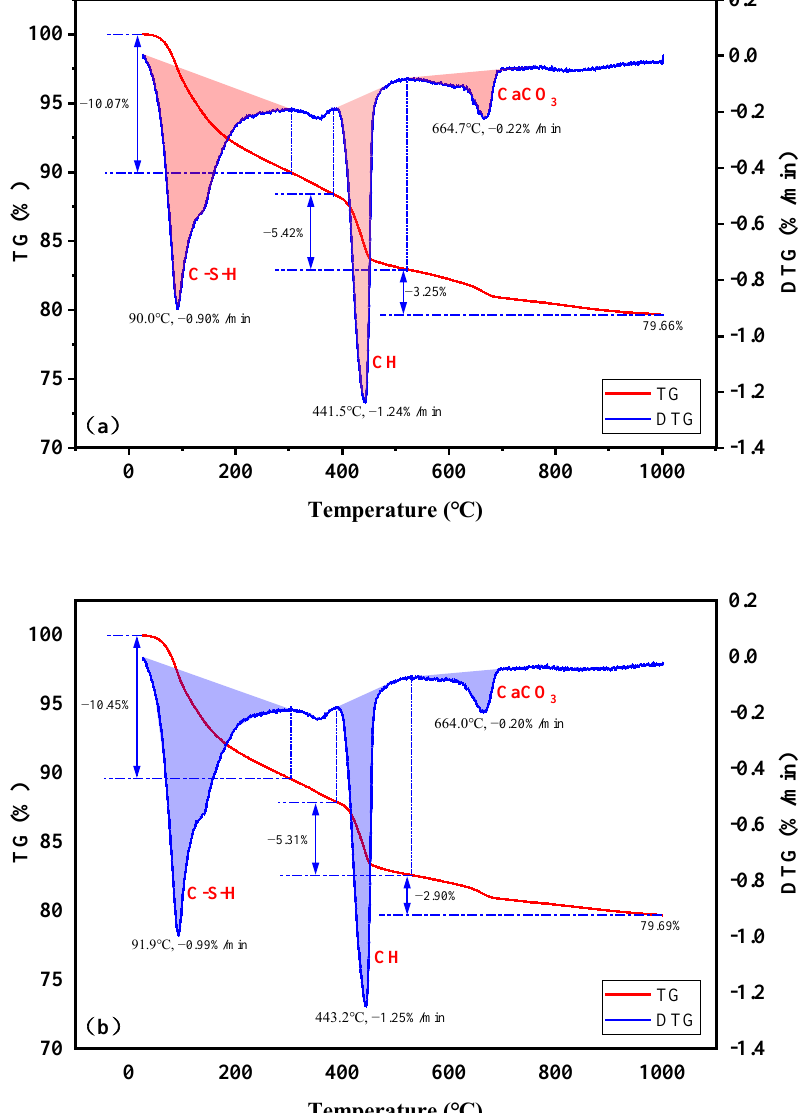
Figure 15. TG and DTG curves of samples: ( a ) OPC; ( b ) DC5.